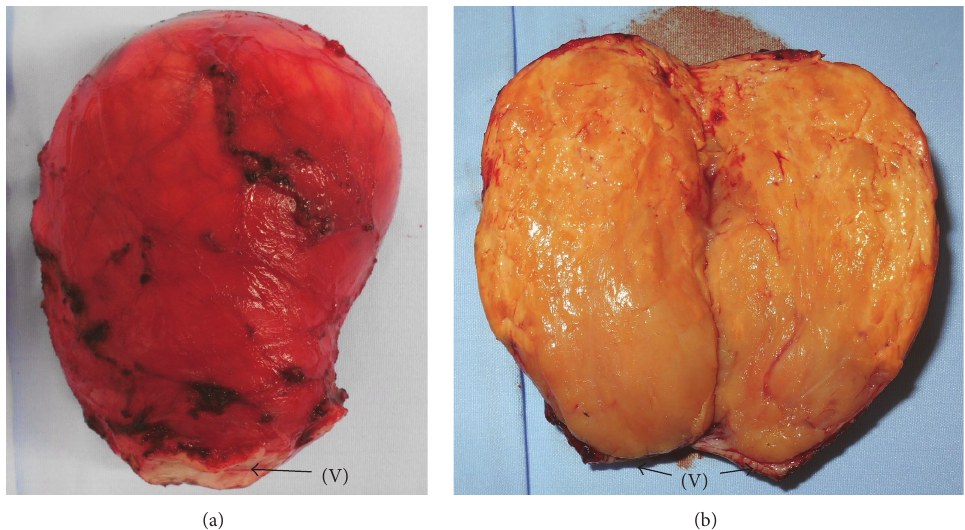
Figure 5: (a) Macroscopic findings of the tumor with connected vaginal (V) tissue. (b) The cut surface of a tumor shows occasional nodules of white fasciculated